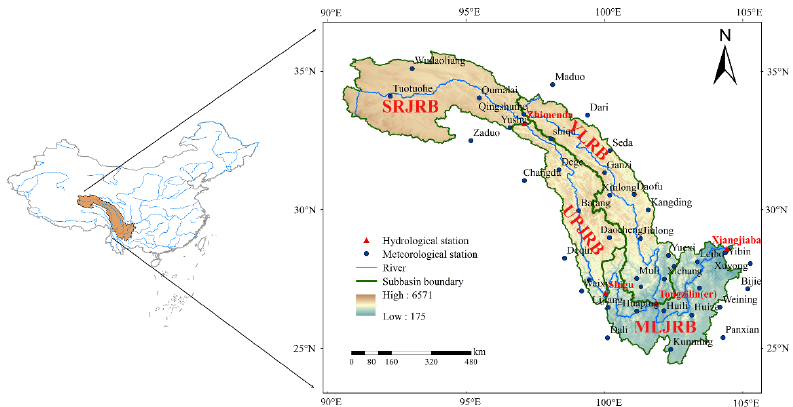
Figure 1. Location of hydrological and meteorological stations, the digital elevation model, and sub-basin boundaries in the Jinsha River Basin, China. The sub-basin boundaries are based on the distribution of hydrological stations and the digital elevation model. Zhimenda, Shigu, and Xingjiaba Stations are located on the main channel while Tongzilin is located on the tributaries. Zhimenda, Tongzilin, and Xiangjiaba are the hydrological control stations of the Source region of the Jinsha River Basin (SRJRB), Yalong River Basin, and the whole Jinsha River Basin. The JRB is important not only for regional economic development and environmental allocation. The total exploitable installed capacity of the JRB for power generation is 59,080